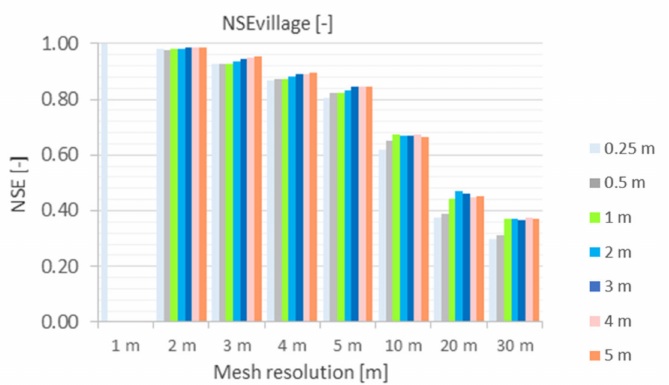
Figure 11. Overview of results of NSE (flow hydrograph) at the control point in the village for the different mesh and DEM resolutions (DEM: colored legend).